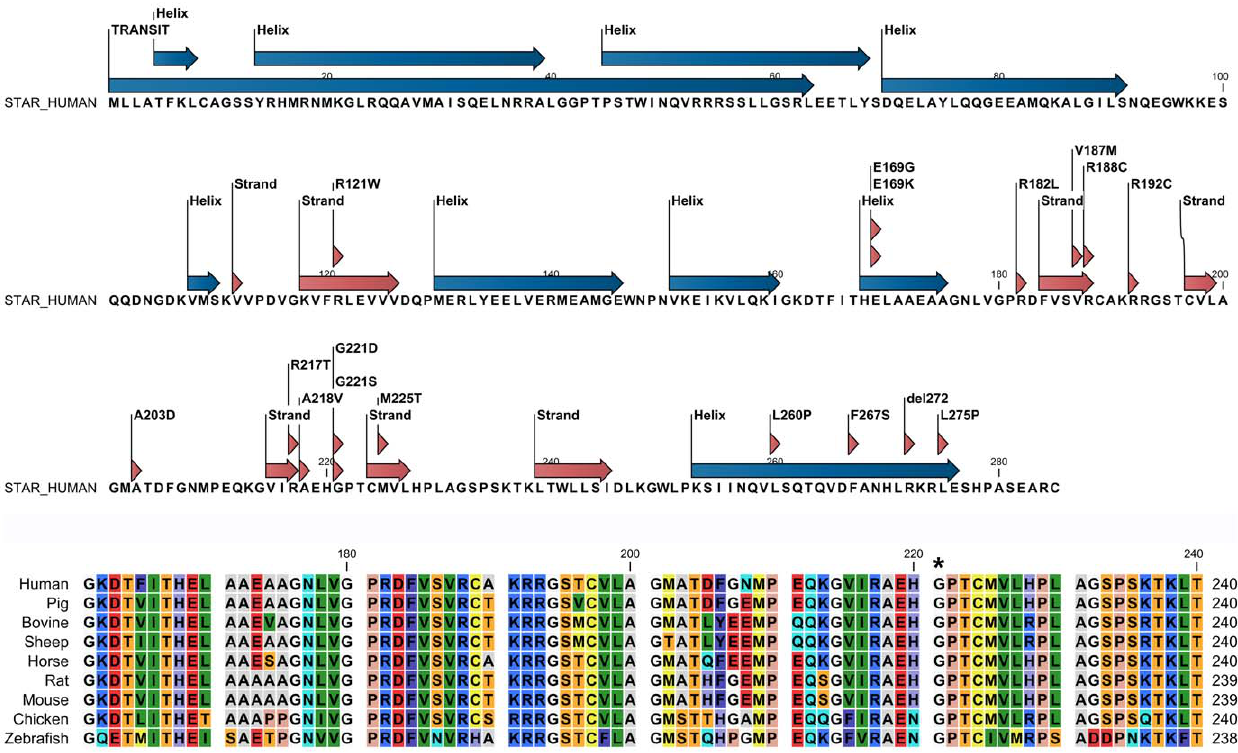
Figure 2. Secondary structural and amino acid conservation of human StAR. (A) A secondary structure prediction was performed to start the model building of human StAR. Locations of amino acids variants of StAR found in UniProt database and pubmed are indicated. (B) A partial sequencing alignment of human StAR amino acid sequence with a range of StAR proteins from other species found in the UniProt database. Overall, StAR amino acid sequence is very well conserved across species with only occasional difference showing up across whole alignment. All major residues at cholesterol binding pocket, E169, R188, R192 and T223 are conserved in all species studied in this analysis, while H220 was found to be replaced with an asparagine in Chicken and Zebrafish, potentially conserving the core structural elements.